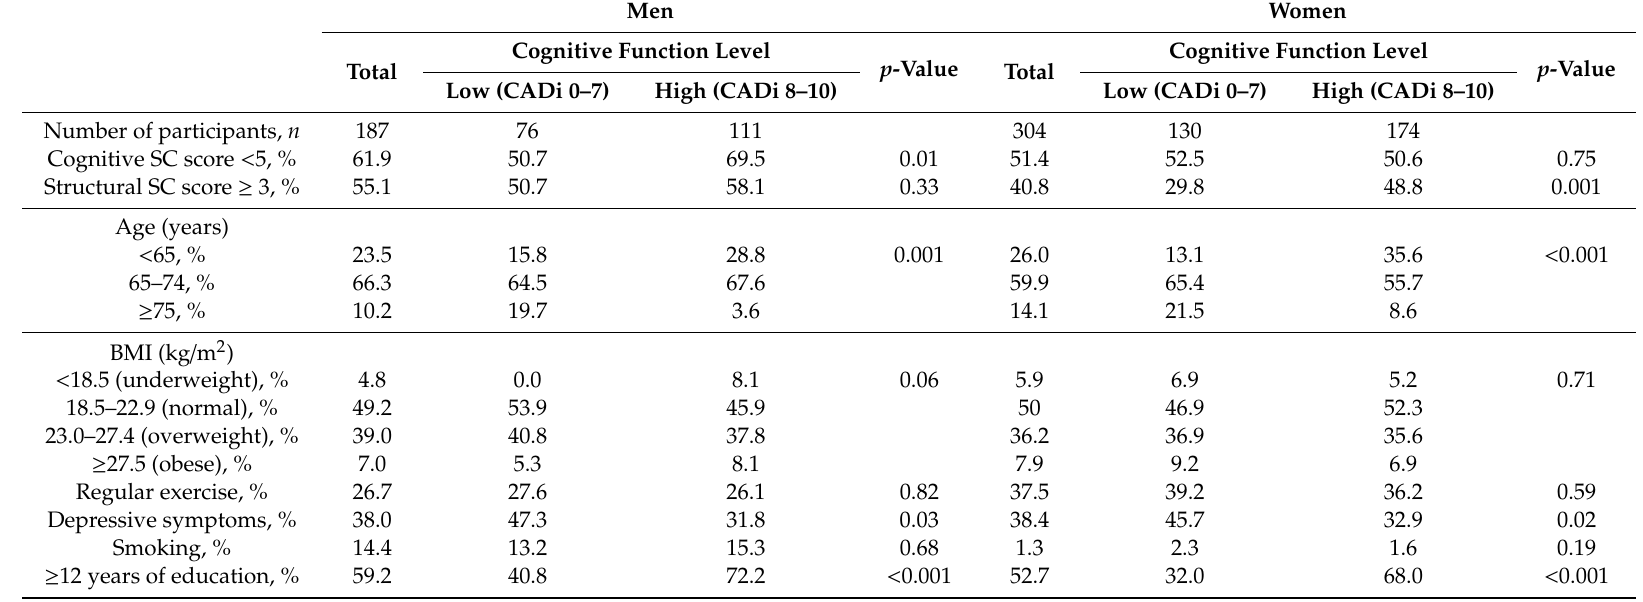
Table 1. Participant characteristics according to gender and cognitive level.